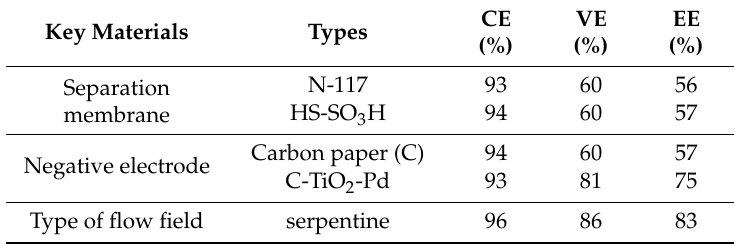
Table 6. The performance of charge-discharge test for the V/I RFB with various key materials.